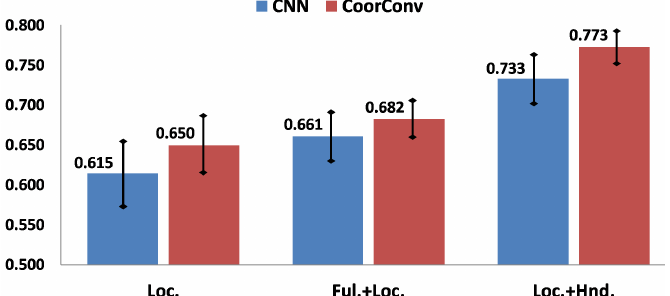
Figure 8. Validation results of multi-stream combinations that includes hand-location features with and without CoorConv network. Y -axis shows the AR